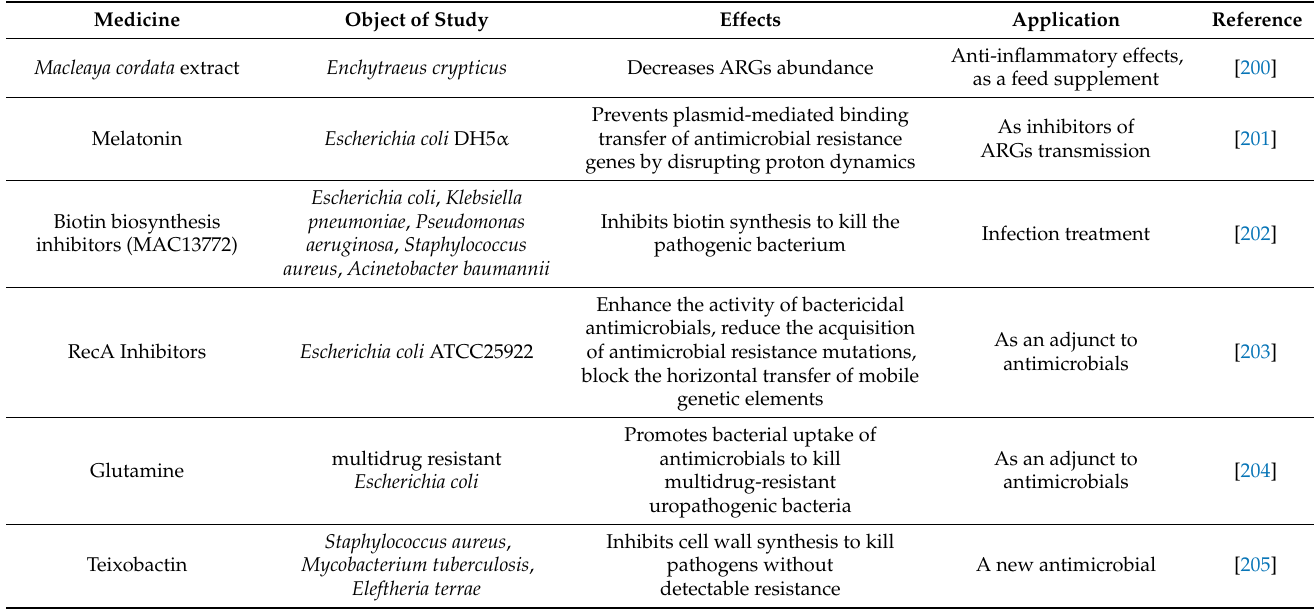
Table 3. New research related to alleviating antimicrobial